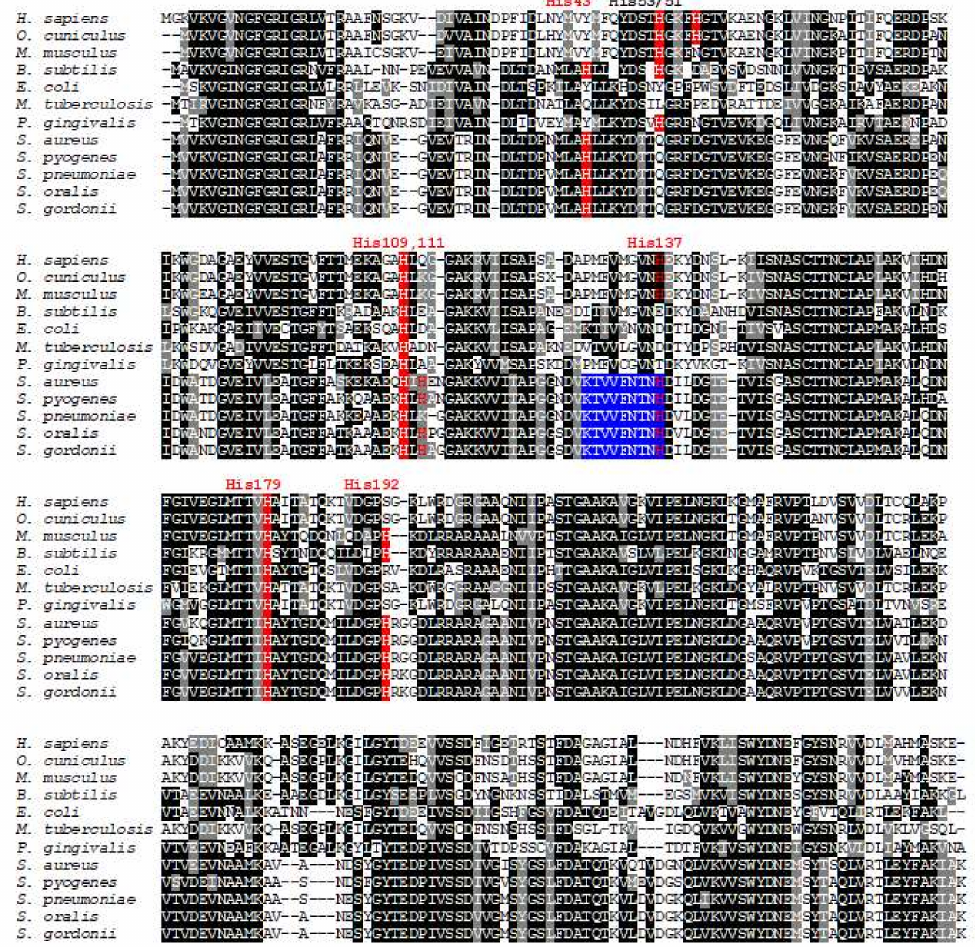
Figure 1. A comparison of amino acid sequences of selected GAPDH proteins. Amino acid residues involved in heme binding in several GAPDH proteins are marked in red. Conserved heme regulatory motif is marked in blue. His53 / 51 - conserved histidine residue engaged in heme coordination in human and rabbit GAPDH, respectively. His43, His109, His111, His137, His179, and His192 histidine residues replaced singly by an alanine residue in this study in SgGAPDH using site-directed mutagenesis are marked in red. Amino acid sequences were identified using BLAST search and compared using the Clustal Omega and the BoxShade